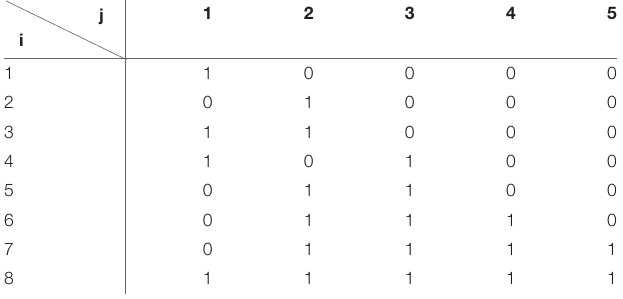
TABLE 2 | Identification of multidimensional health poverty under different indexes. Dimension Health poverty Health poverty defined defined by MHPI by conditional